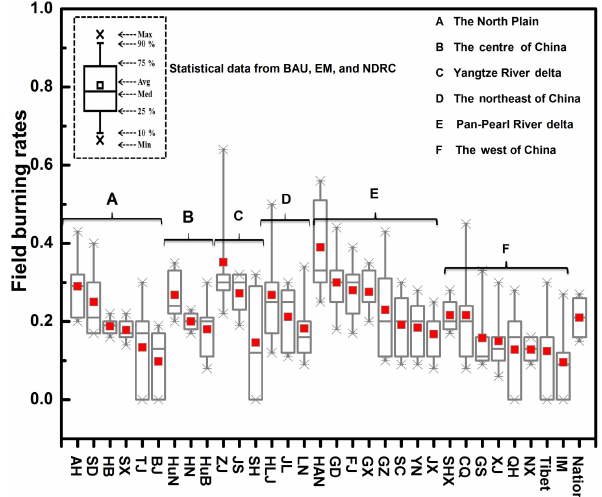
Figure 6. Statistical analysis of field burning rates from BAU, EM, and NDRC